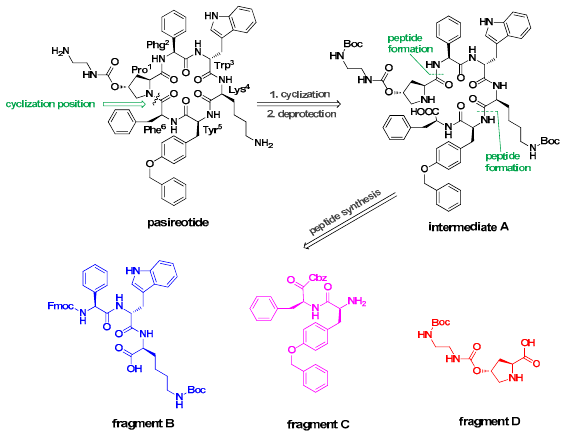
Scheme 1. Structure of pasireotide A and our retrosynthetic analysis.